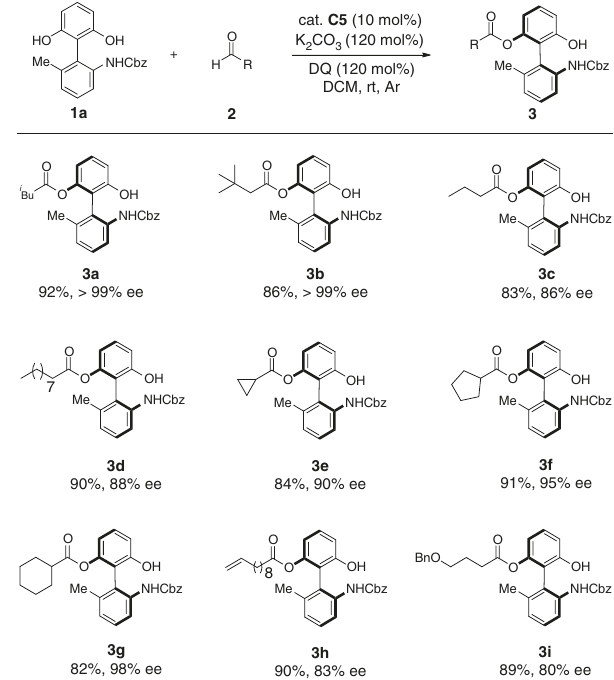
Fig. 2 Scope of aldehydes. Reaction conditions: a mixture of 1a (0.10